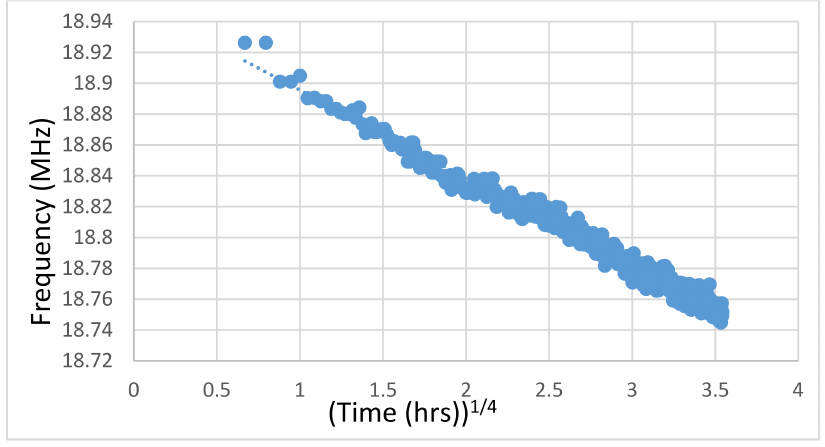
Figure 5. Plot of frequency degradation of a RO composed of 101 stages. It is plotted to a 4th root power law creating a straight line from a